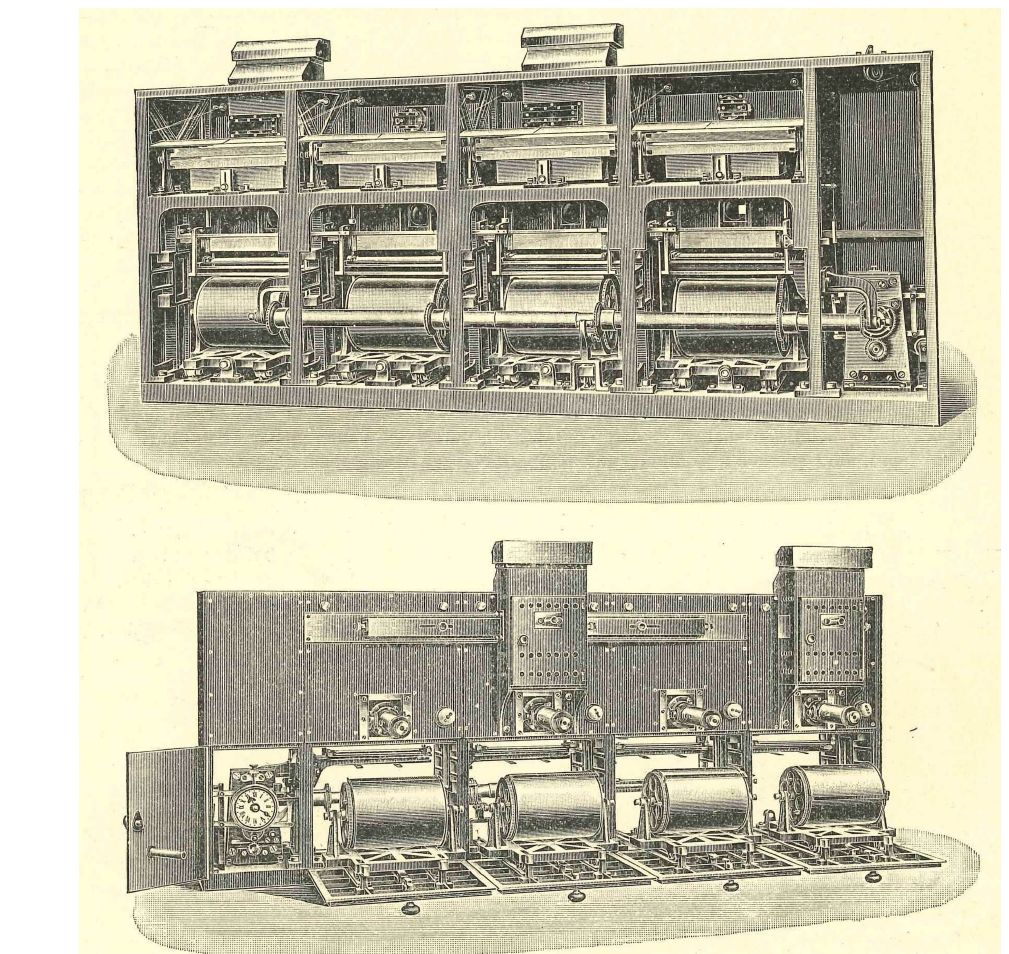
Figure 6. Recording equipment of the observatory building northern room. View from the instrument room (top) and view from the vestibule (bottom). Source: Schmidt (1910).